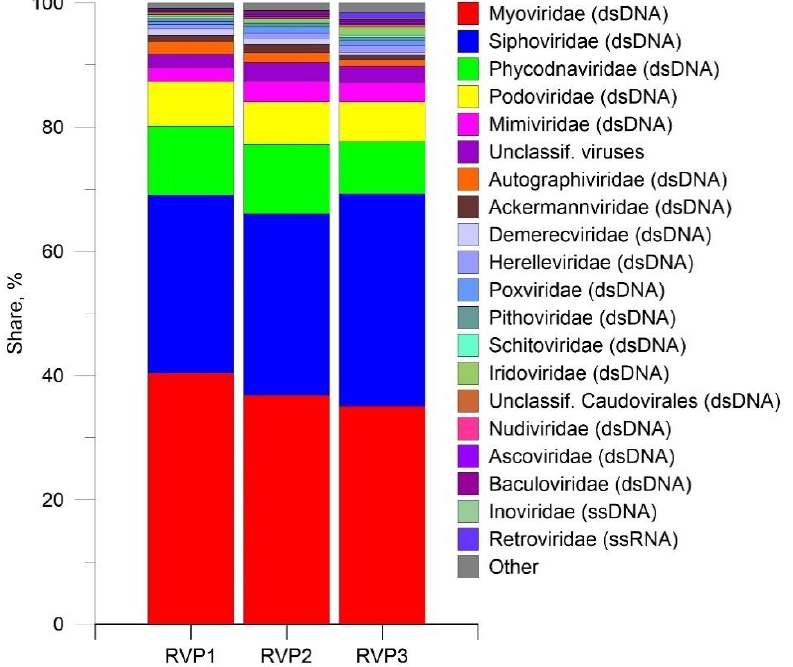
Figure 3. Abundance of viral taxa at the family level in the transcriptomes of Lake Baikal.